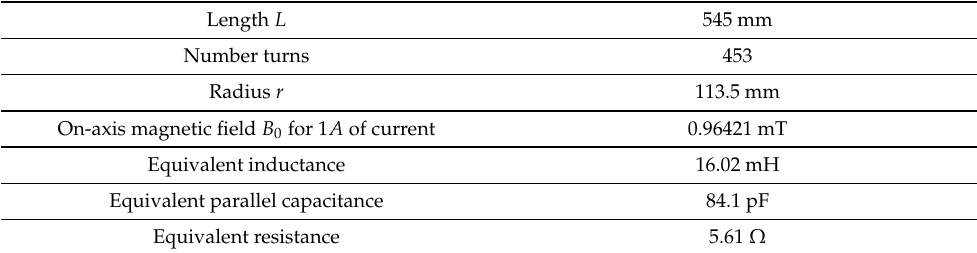
Figure 4. Finite rectilinear uniform solenoid adopted as source of reference magnetic field. Table 2. Main parameters of the external layer of the solenoid.